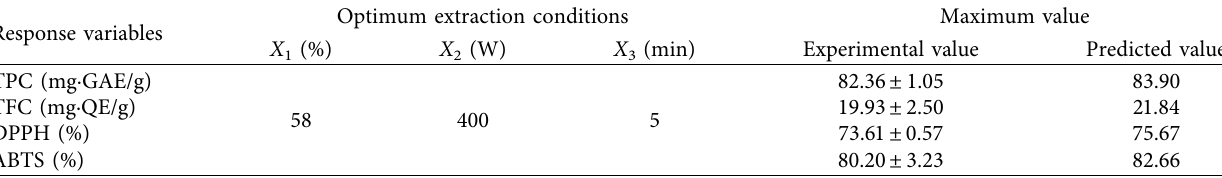
Table 4: Experimental and predicted values of response variables at optimum extraction